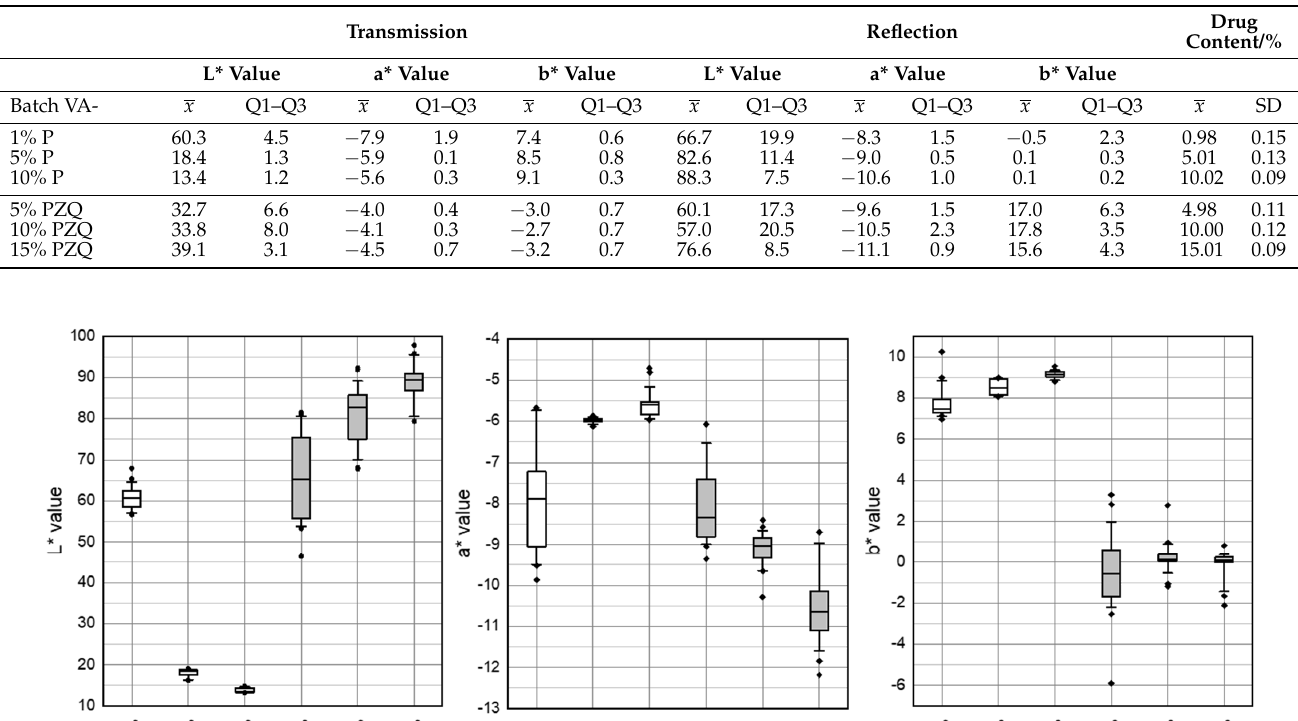
Table 2. L*a*b* values of transmission and reflection measurement of the filaments obtained with Setup 1 ( n = 10; mean, Q1-Q3) despite the analyzed content uniformity determined by HPLC analysis ( n = 10; mean, SD).